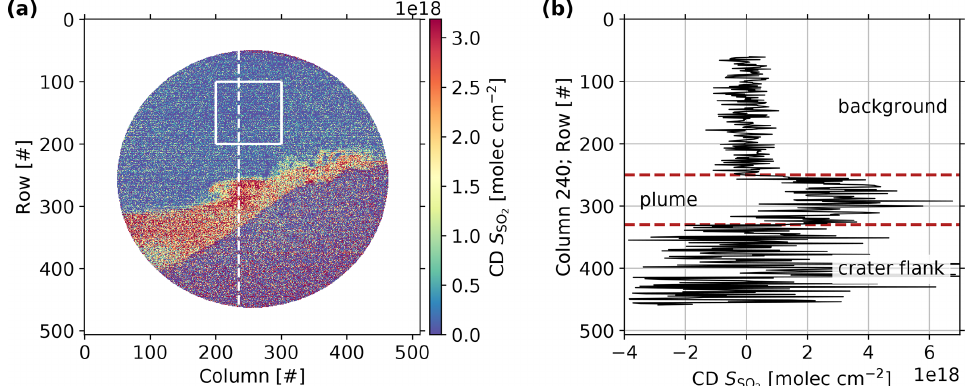
Figure 7. (a) Volcanic plume SO 2 CD distribution calculated from images acquired with the IFPICS prototype and using the instrument ) (see Eq. 8). The plume-free area indicated by a white square (100 × 100 pixels) is used to ( ˜ τ SO forward model conversion function S SO 2 2 correct for atmospheric background and to obtain an estimation for the detection limit. (b) Individual SO 2 CD column 240 (indicated by dashed white line in a ) showing that the background, plume, and crater flank region are clearly distinguishable. High scattering in the crater flank region is induced by low